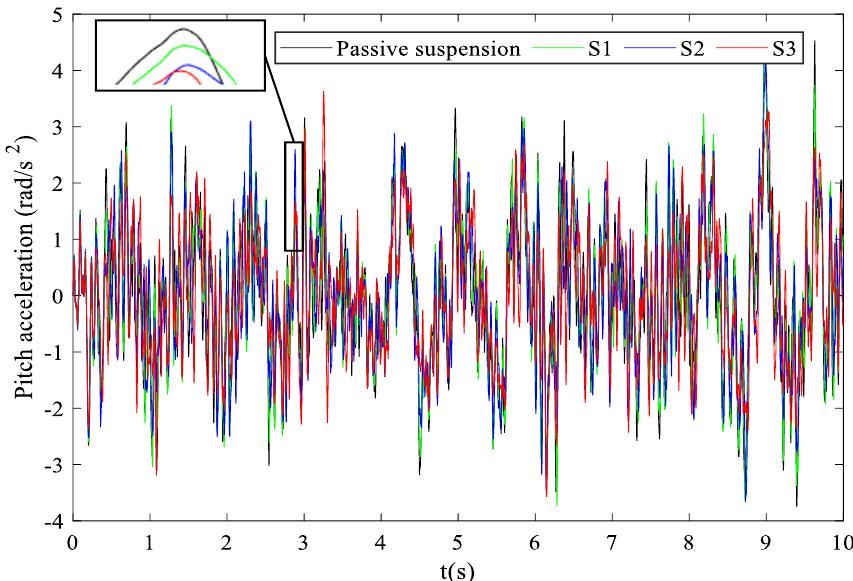
Figure 7. Comparison of the pitch accelerations in the time domain.